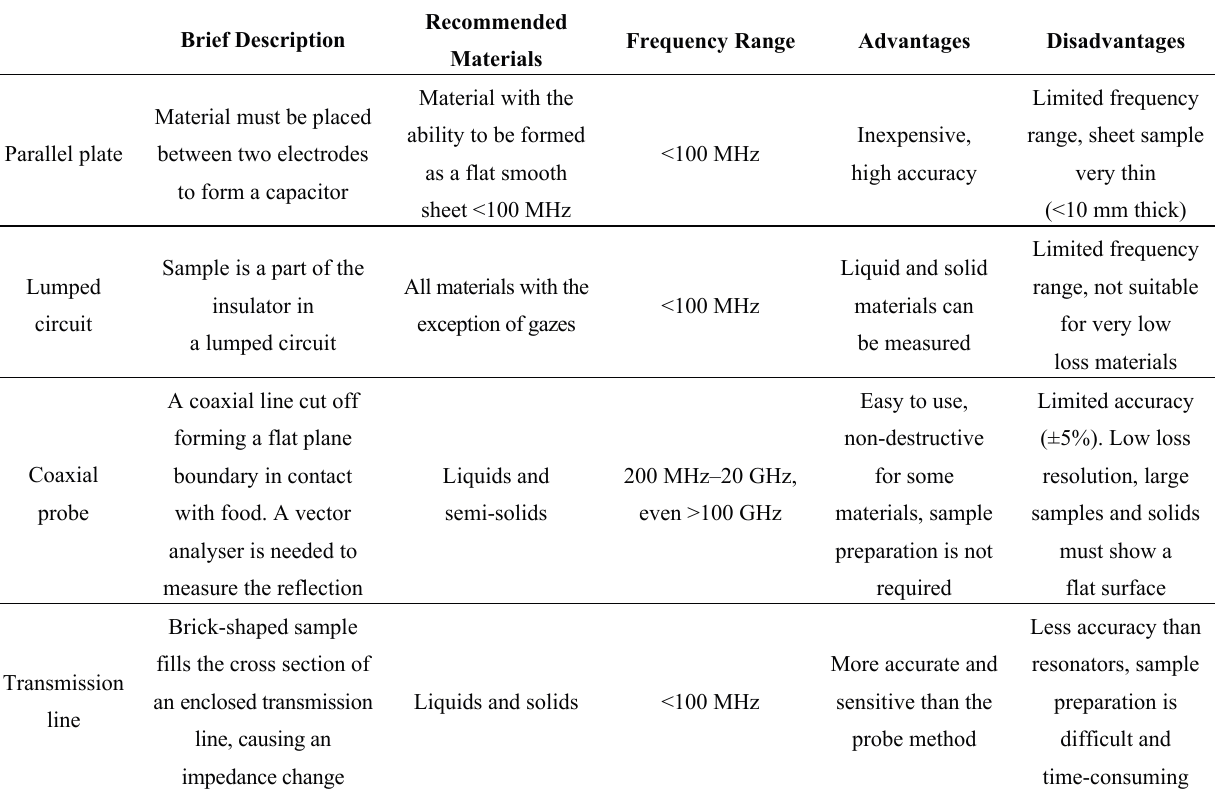
Table 1. Dielectric